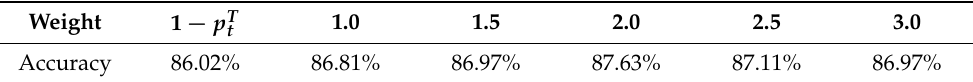
Table 2. The experimental comparison results of different NCKD weights. The experiments were conducted under the conditions of the simultaneous implementation of image enhancement for both the teacher and student models.